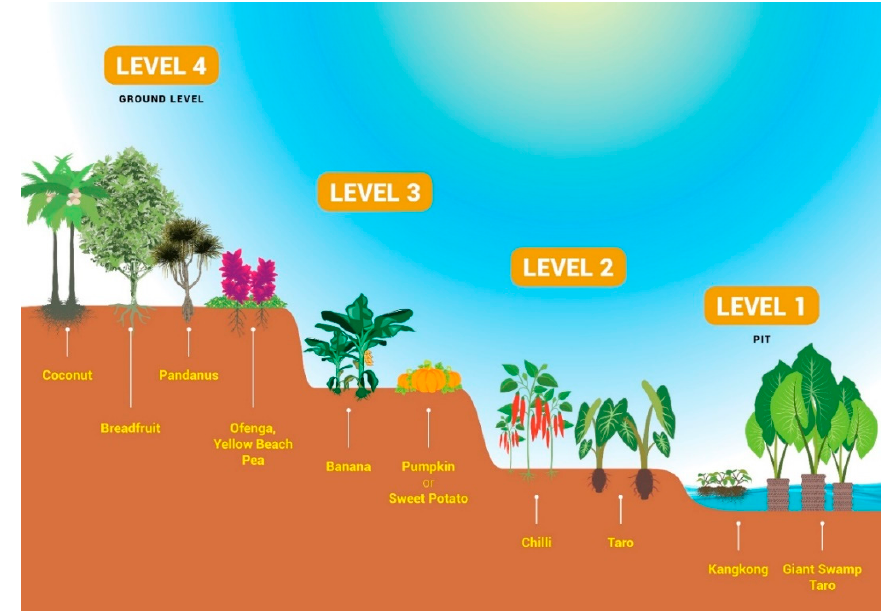
Figure 2. Layout of a babai/pulaka food garden. Other nutritious food crops can be substituted or added if desired.